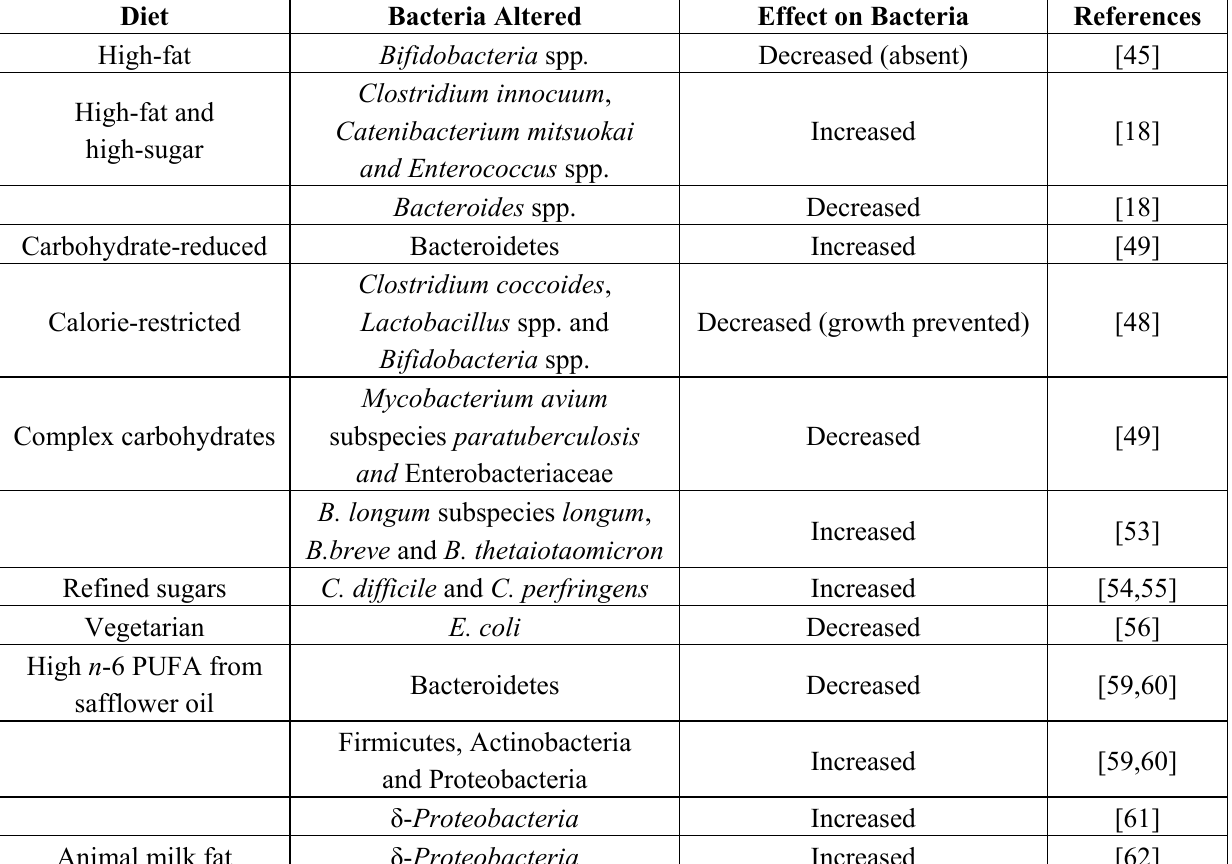
Table 1. Summary of diet-induced